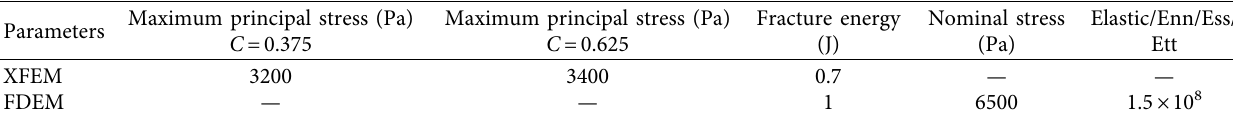
Table 3: The parameters for the XFEM and FDEM